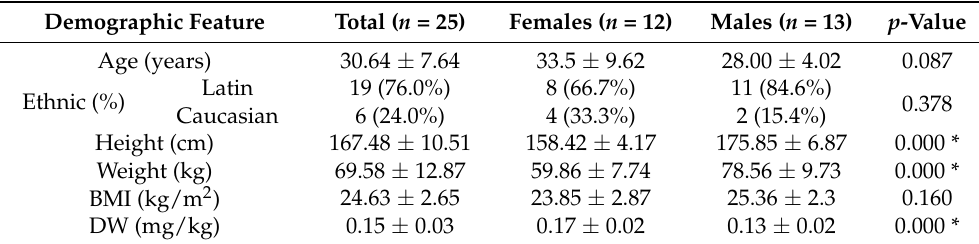
Table 1. Demographic characteristics of the study participants.